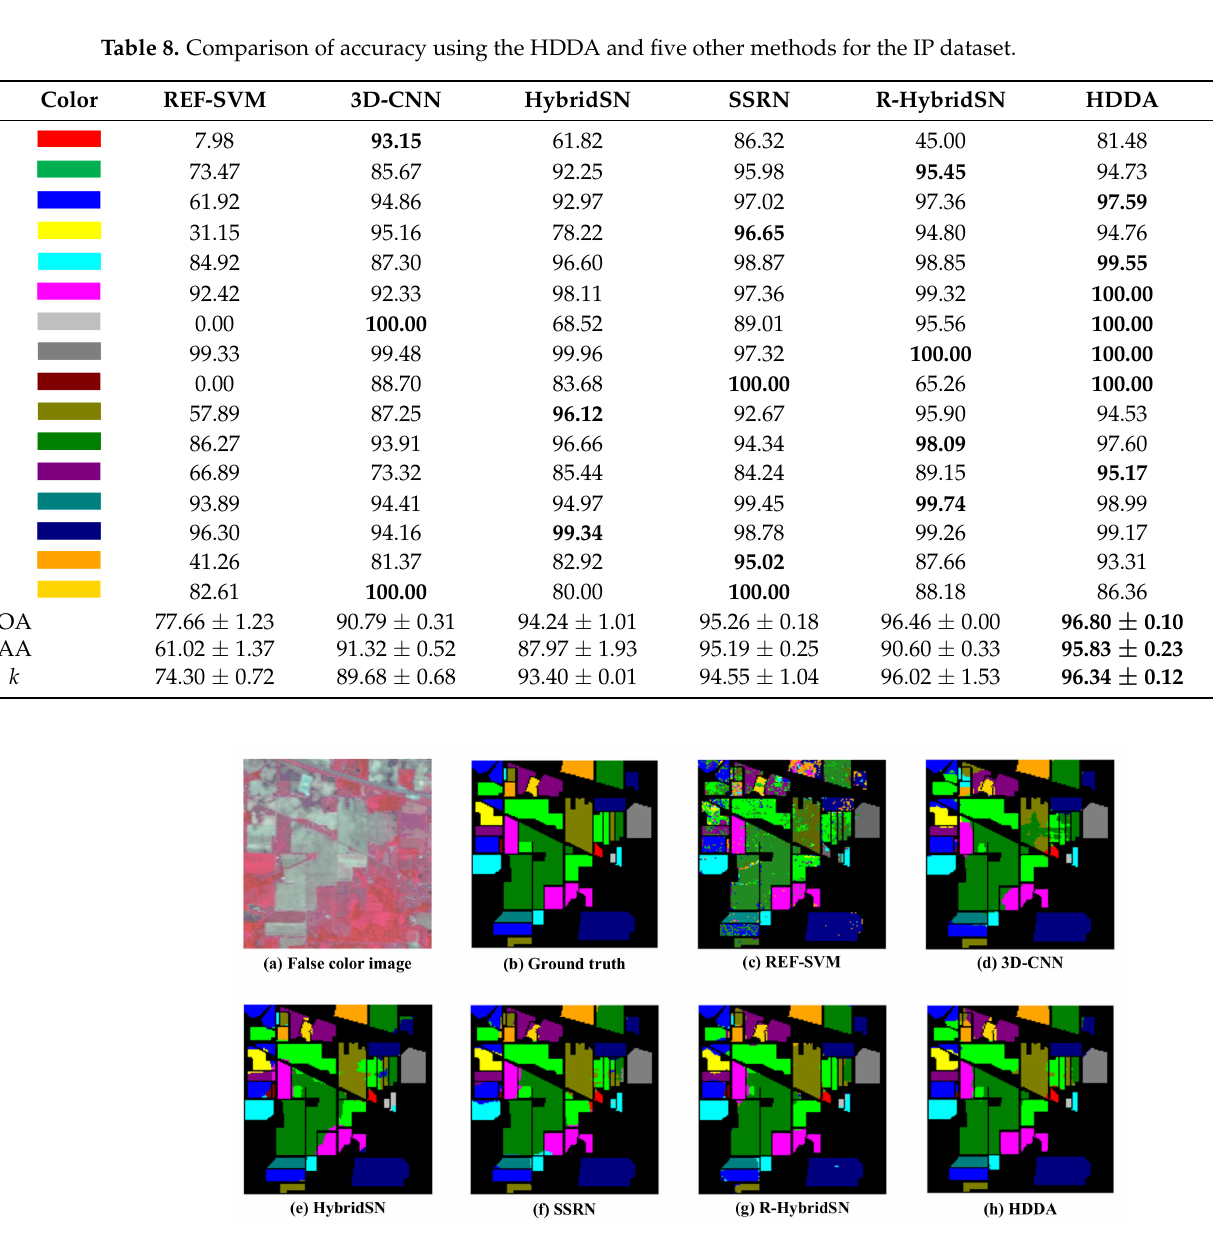
Figure 12. Classification maps using only the training samples (5% of total samples) for the IP dataset. ( a ) False color image; ( b ) Ground truth; ( c ) REF-SVM; ( d ) 3D-CNN; ( e ) HybridSN; ( f ) SSRN; ( g ) R-HybridSN; ( h )